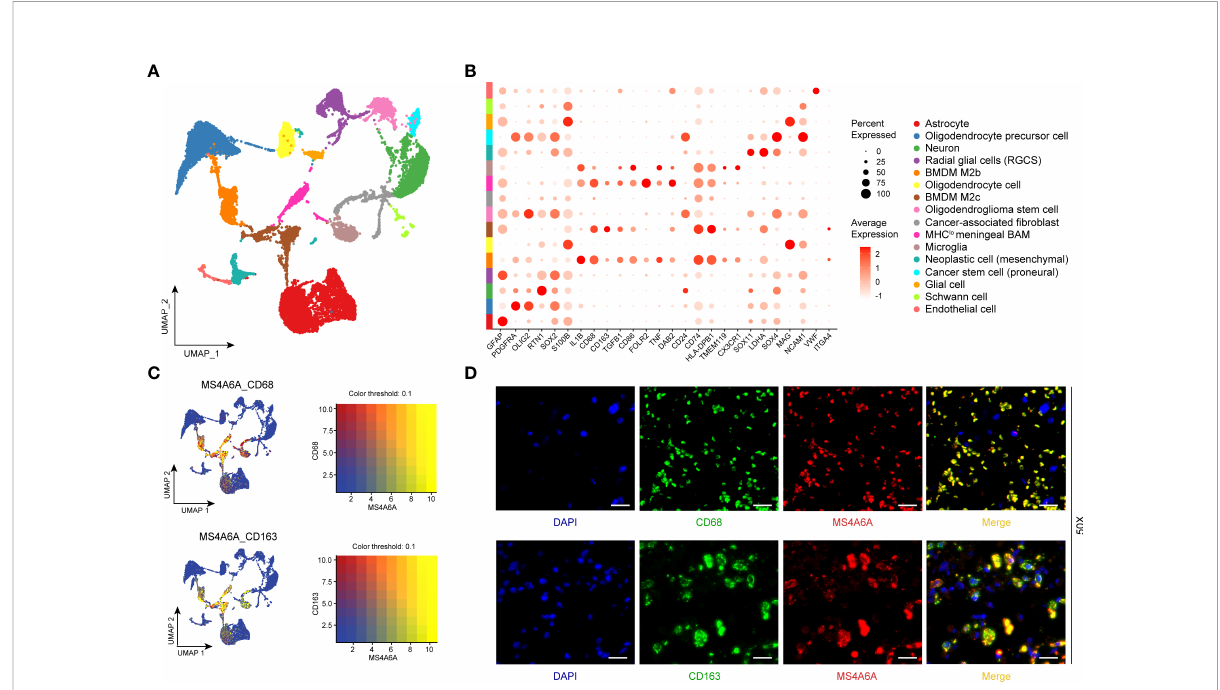
FIGURE 6 Single-cell RNA-seq analysis and immuno fl uorescent (IF) staining.UMAP plot mapping assigned cell types across glioma samples ( N = 10). Each cell type is de fi ned by a speci fi c color (A) . Dot plot of gene expression of marker genes selected in each subcluster. Rows depict cell types, and columns describe signatures (B) . UMAP plots illustrate the coexpression patterns of MS4A6A, CD68, and CD163 (C) in scRNA-seq samples. Representative immuno fl uorescent lf staining images reveal colocalization of MS4A6A/CD68 and MS4A6A/CD163 in glioma tissues. Scale bar, 20 m m (D) . Abbreviations: BMDM: bone marrow-derived macrophages; BAM: border-associated